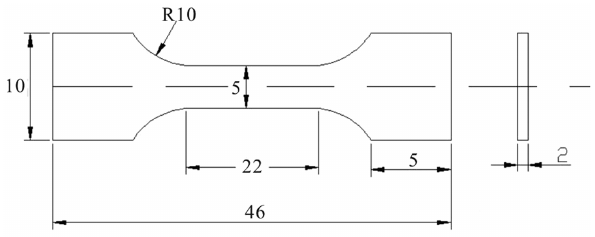
Figure 1: Schematic of tensile specimens.